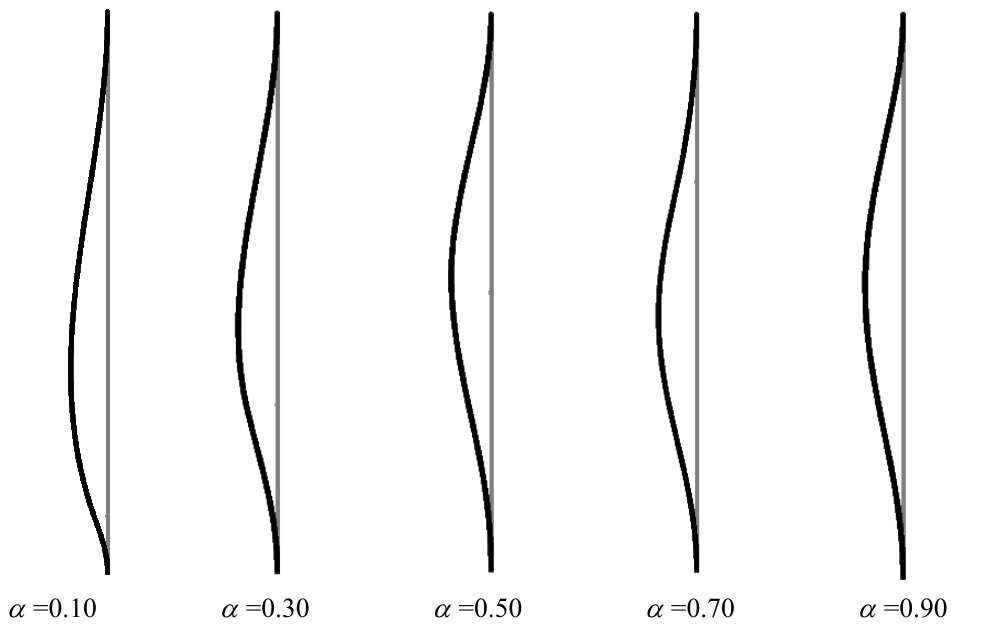
Fig. 2. Effect of the intermediate load location in the buckling shape of the stepped column (C-C